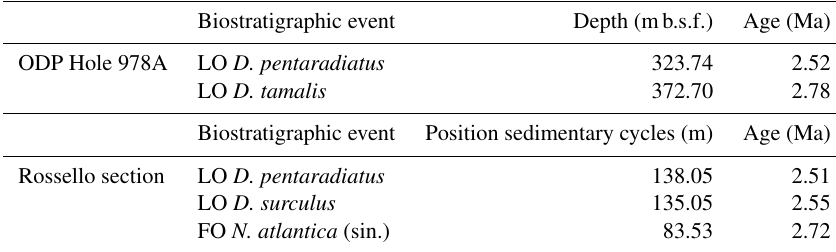
Figure 2. (a) Stratigraphic framework established for the ODP Hole 978A record based on indicated biostratigraphic tie points (FO: first occurrence; LO: last occurrence) and visual correlation of the δ 18 O record with the Rossello section (Lourens et al., 1996). (b) Calculated sedimentation rates. Table 1. Biostratigraphic events of ODP Hole 978A (Comas et al., 1996) and the Rossello section (Lourens et al., 1996) used for the establishment of age constraints of the upper ODP 978A (Fig. 2a). FO: first occurrence; LO: last